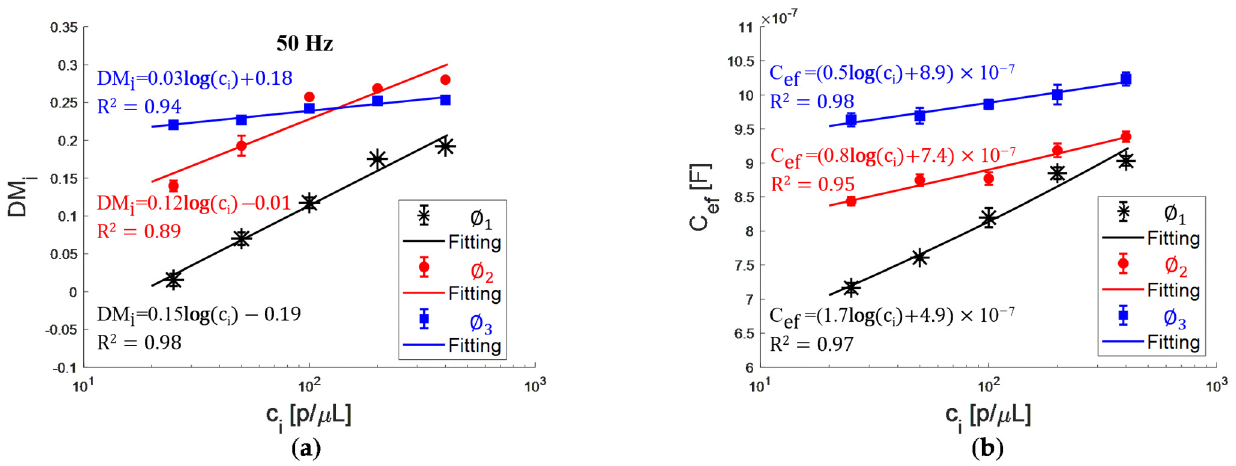
Figure 5. ( a ) DM (cid:2919) at 50 Hz and ( b ) C (cid:2915)(cid:2916) as a function of PMMA particle concentration for ∅ (cid:2869) , ∅ (cid:2870) , and ∅ (cid:2871) (symbols-data and solid